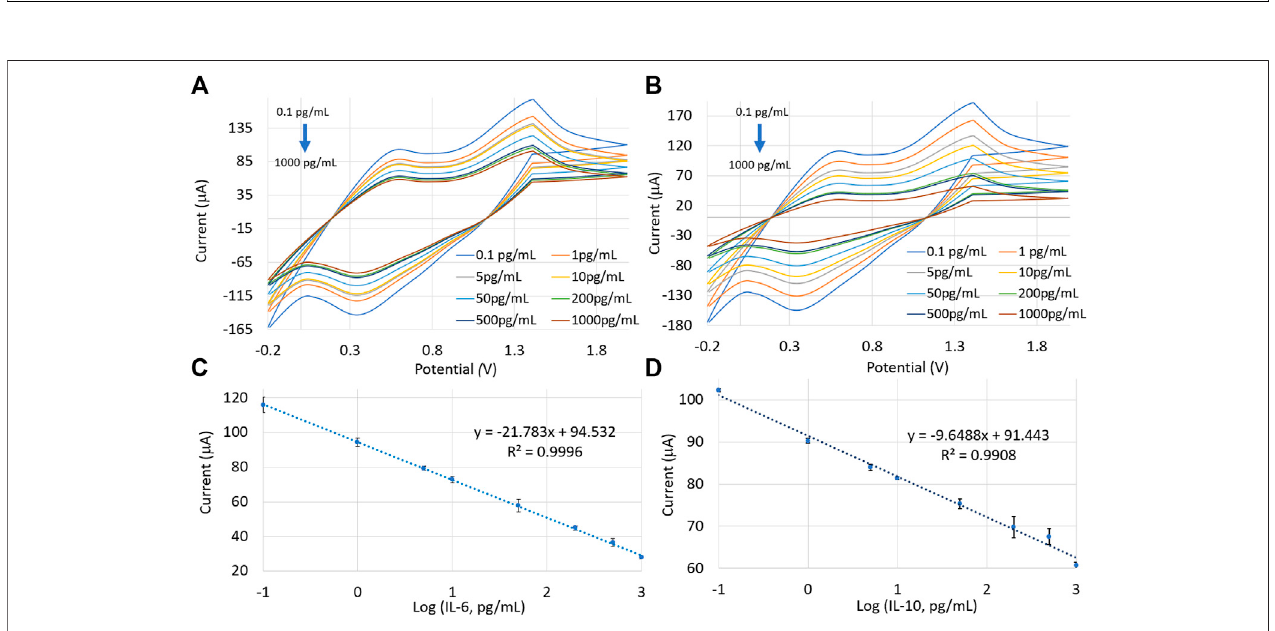
FIGURE 8 | CV plots for different concentrations of (A) IL-6 and (B) IL-10, using the developed potentiostat. Calibration curves were generated by plotting current responses as a function of (C) IL-6 and (D) IL-10 concentrations. Measurements were repeated three times for each protein